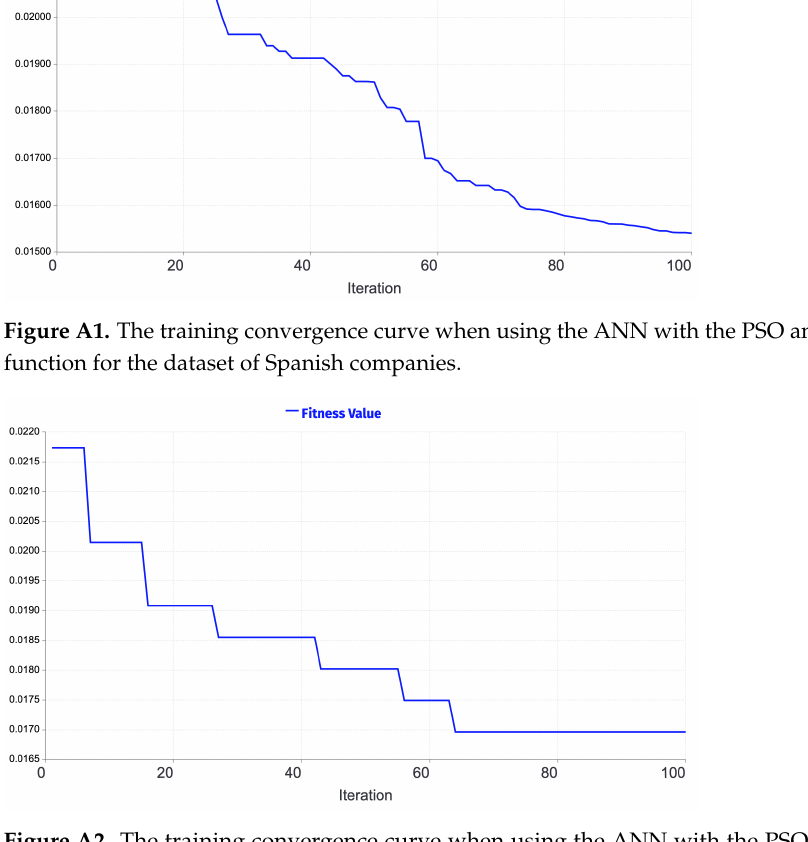
Figure A2. The training convergence curve when using the ANN with the PSO and the accuracy fitness function for the dataset of Spanish